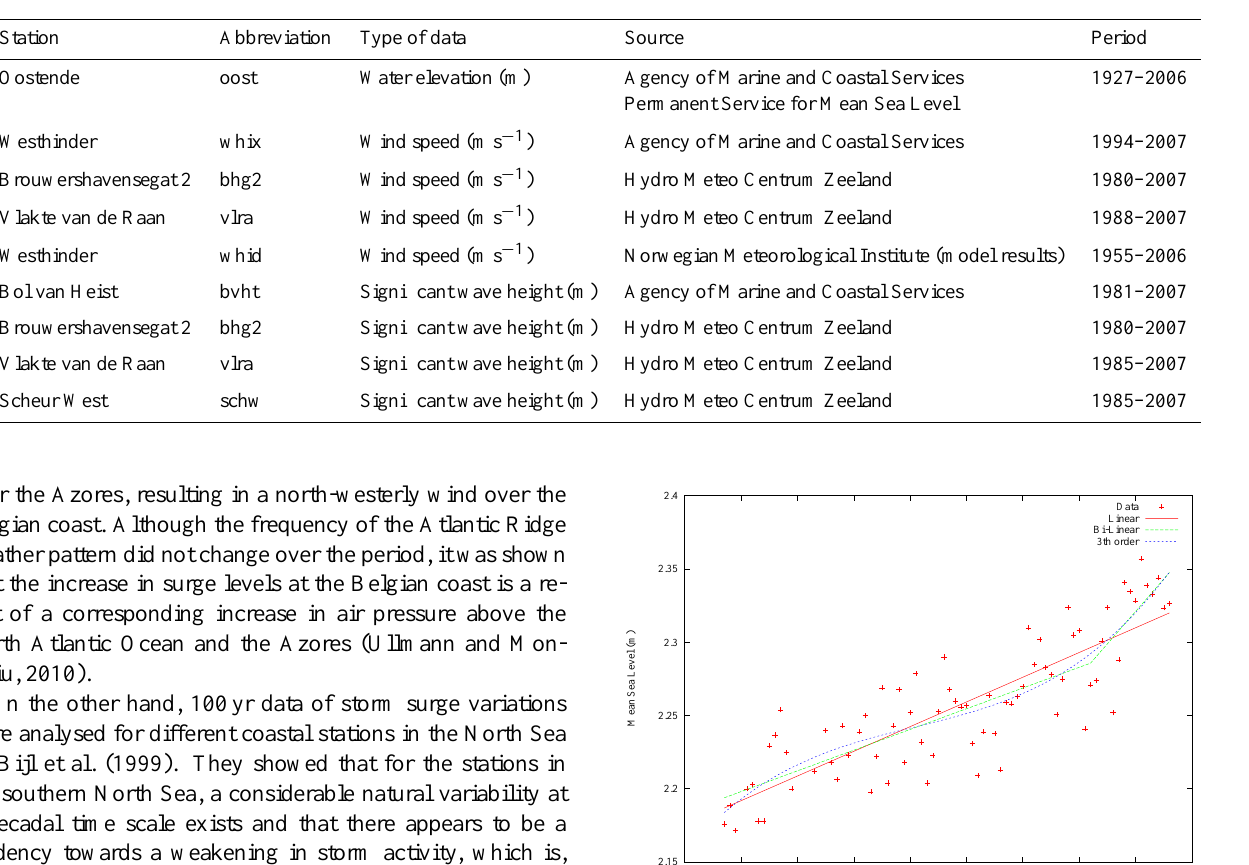
Table 1. Position of the stations and data used in the analysis.